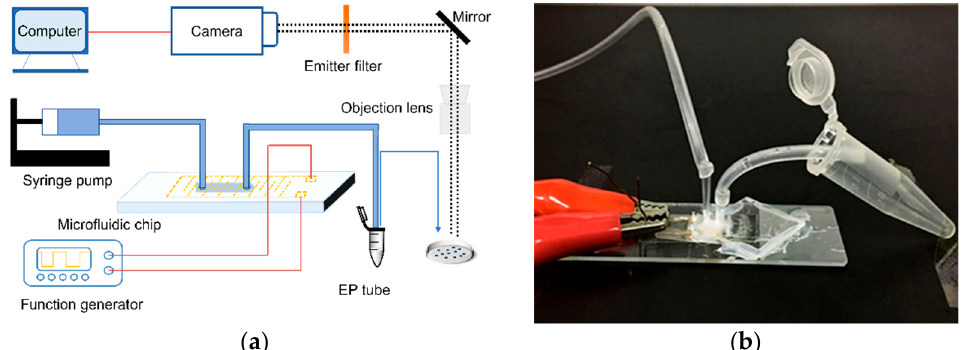
Figure 2. Schematic diagram of the experimental devices. ( a ) Experimental setup. ( b ) In the microfluidic chip, the left-side hose was used to inject E. coli dilution, and the right-side hose was used to drain the lysate into an EP tube for collection.